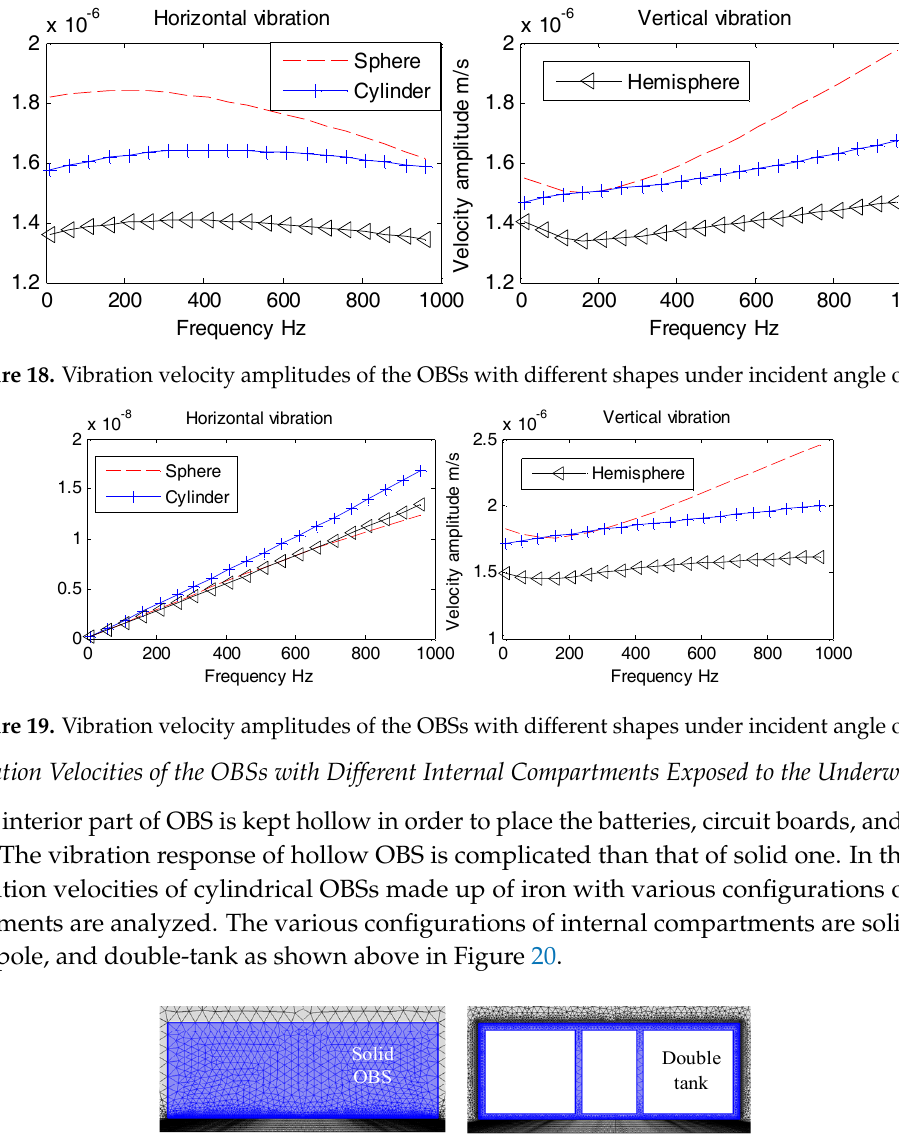
Figure 17. Vibration velocity amplitudes of the OBSs with different shapes under incident angle of 10°.